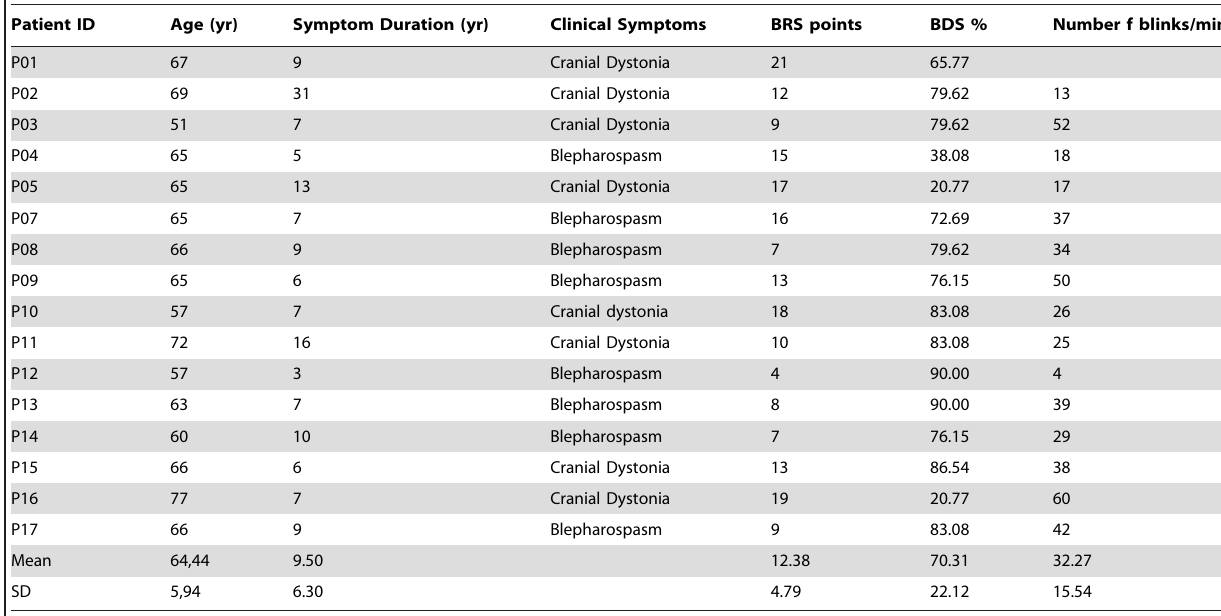
Table 1. Clinical characteristics of patients.